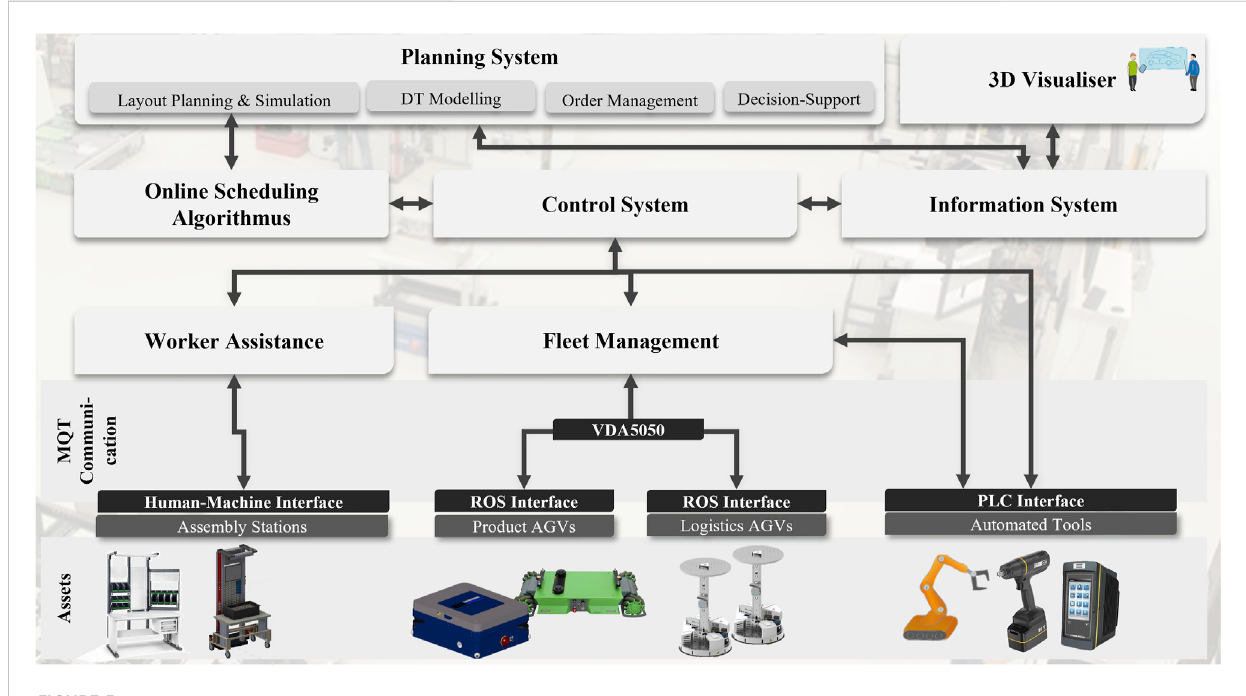
FIGURE 5 Implemented software architecture of the line-less assembly